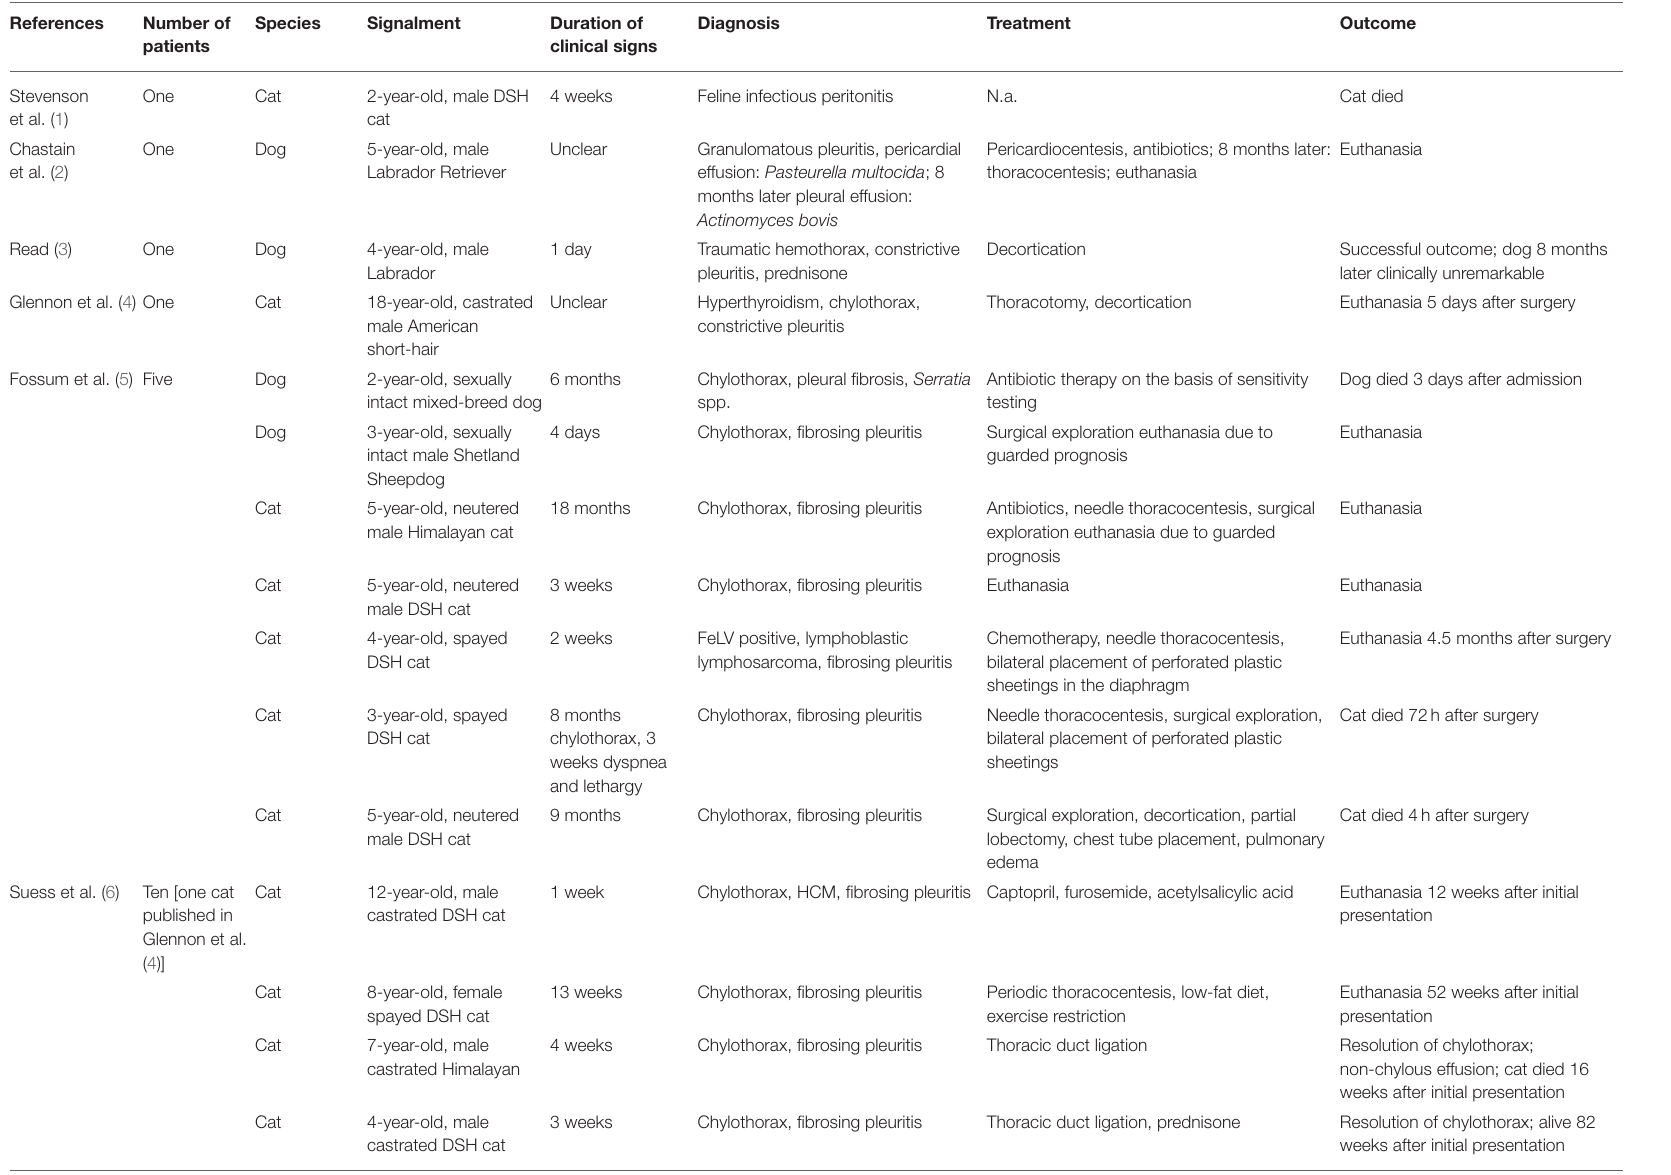
TABLE 1 | Summary of current literature about fibrosing pleuritis in dogs and